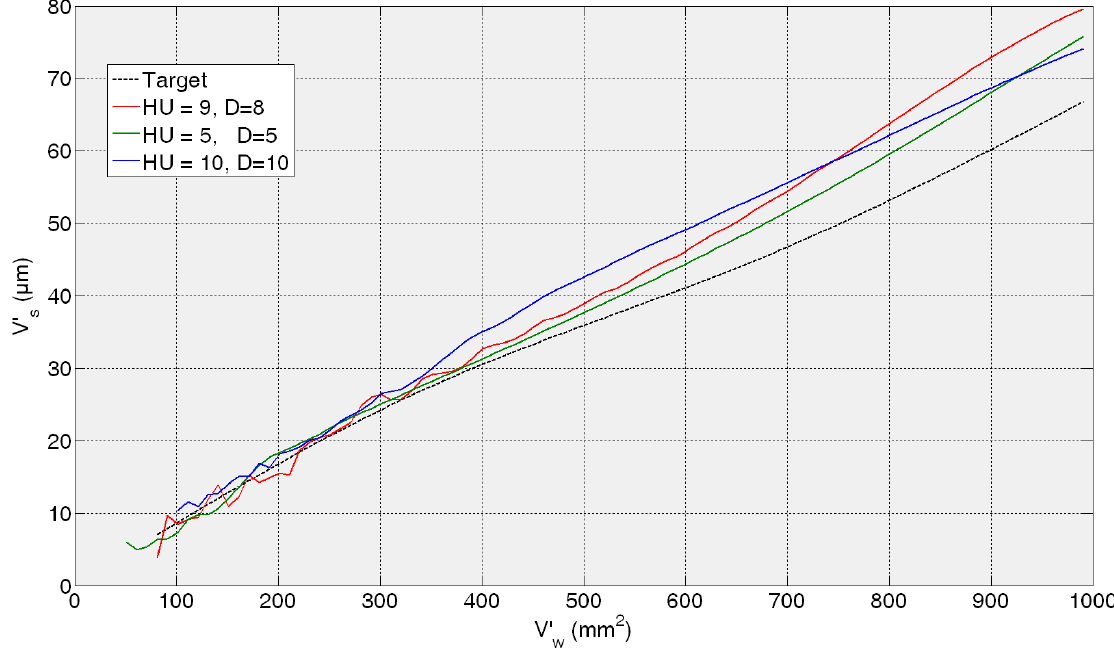
Figure 7. Generalization capability of the three preselected configurations . Test experiment : 82AA36K6VW q = 100; Q' = s